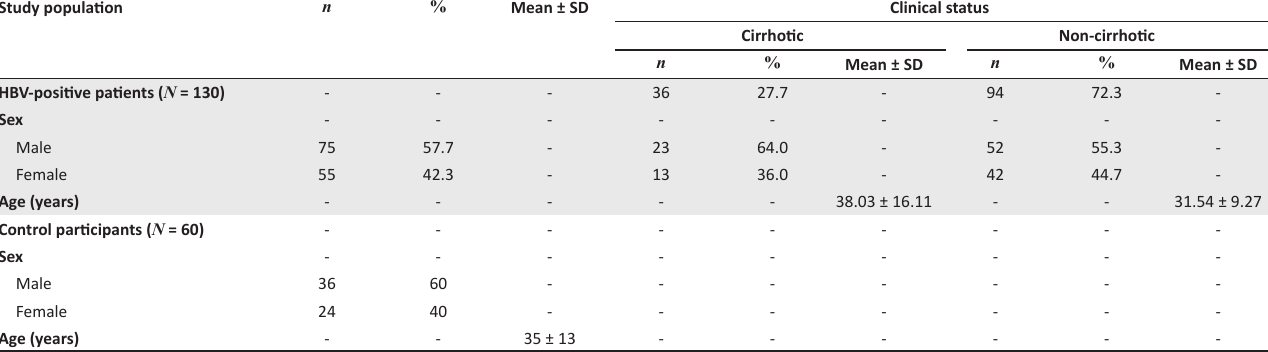
TABLE 1: Social and clinical characteristics of hepatitis B virus-positive patients at Yaoundé General Hospital, Cameroon, September–December 2018. Study